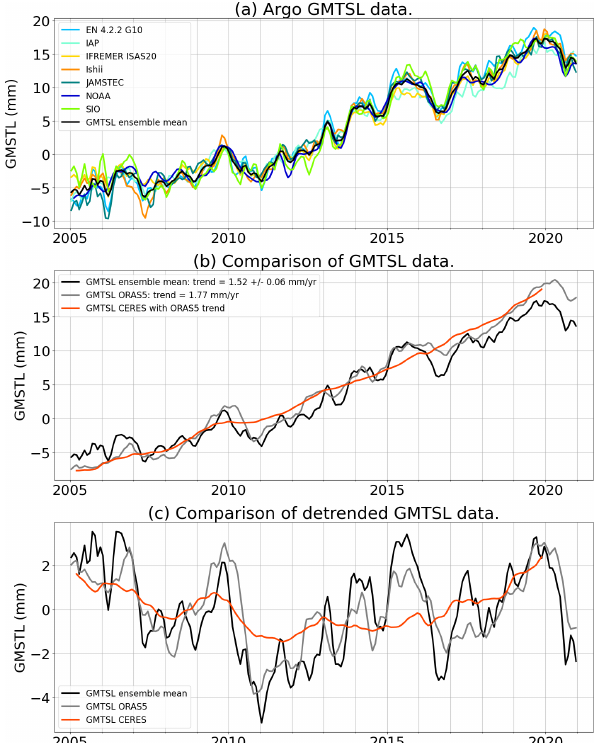
Figure 5. Global mean thermosteric sea level (GMTSL) variations time series. (a) GMTSL from the seven datasets based on in situ measurements used in this study. The black curve corresponds to the ensemble mean. Linear trends of all time series over different periods of time are provided in Table S1. (b) Comparison of the GMTS estimates from in situ data, ORAS5 reanalysis and CERES observations. (c) Comparison of the detrended GMTSL time